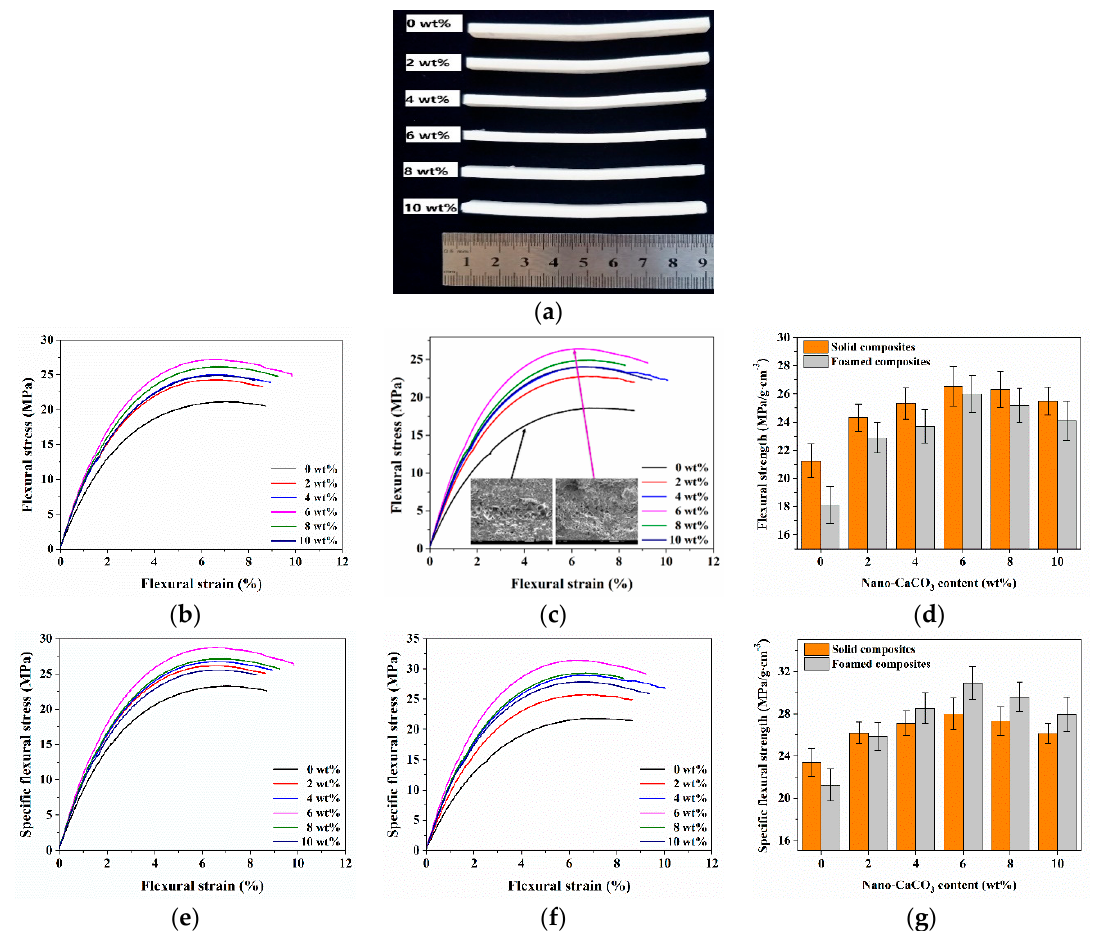
Figure 7. Flexural results of solid and foamed composites: ( a ) foamed samples after flexural tests; ( b , c ) flexural stress strain curves of solid and foamed composites, respectively; ( d ) the flexural strength; ( e , f ) specific flexural stress strain curves of solid and foamed composites, respectively; ( g ) the specific flexural strength.